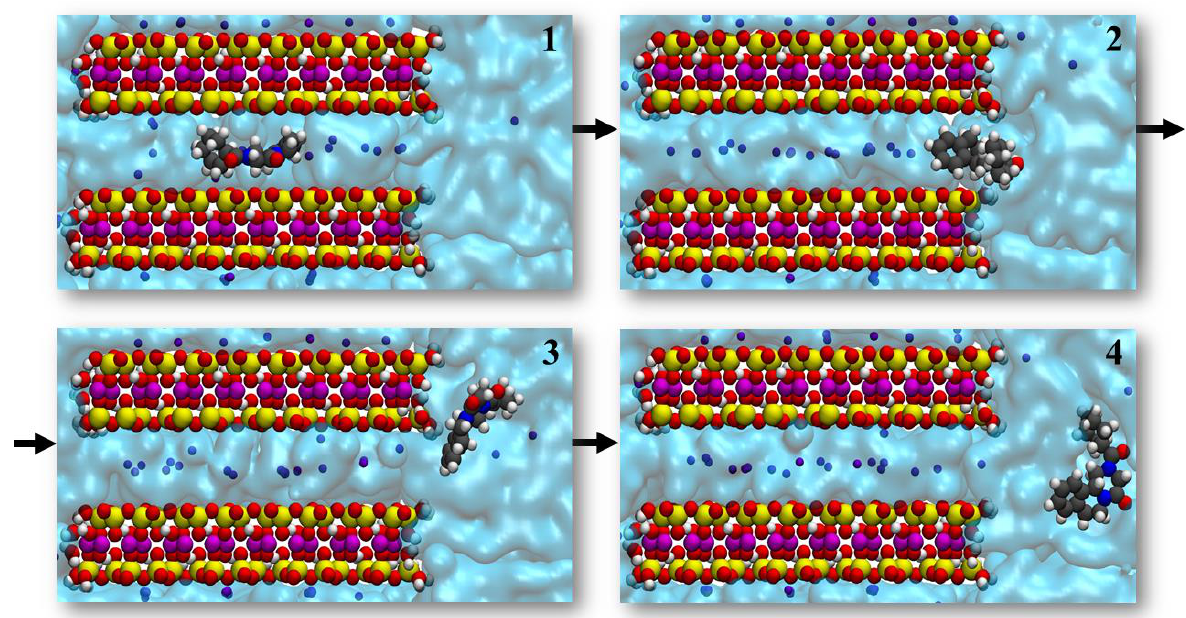
Figure 5. Praziquantel release mechanism from the interlayer space of the montmorillonite in aqueous solution.